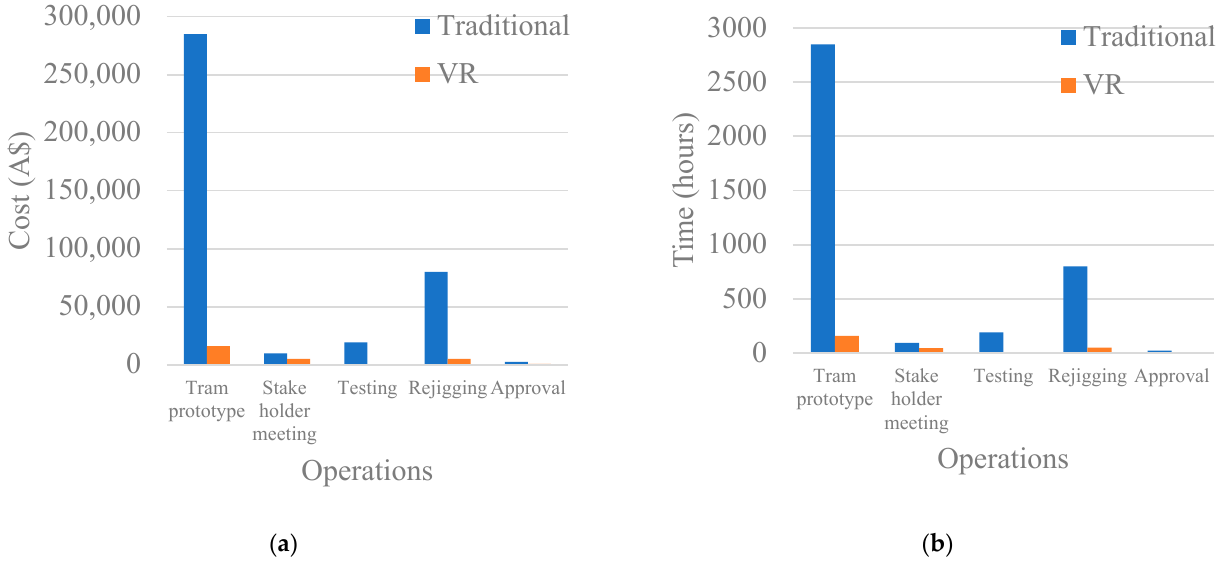
Figure 7. Analysis of traditional versus Metaverse-based studies by ( a ) Cost ( b ) Time.